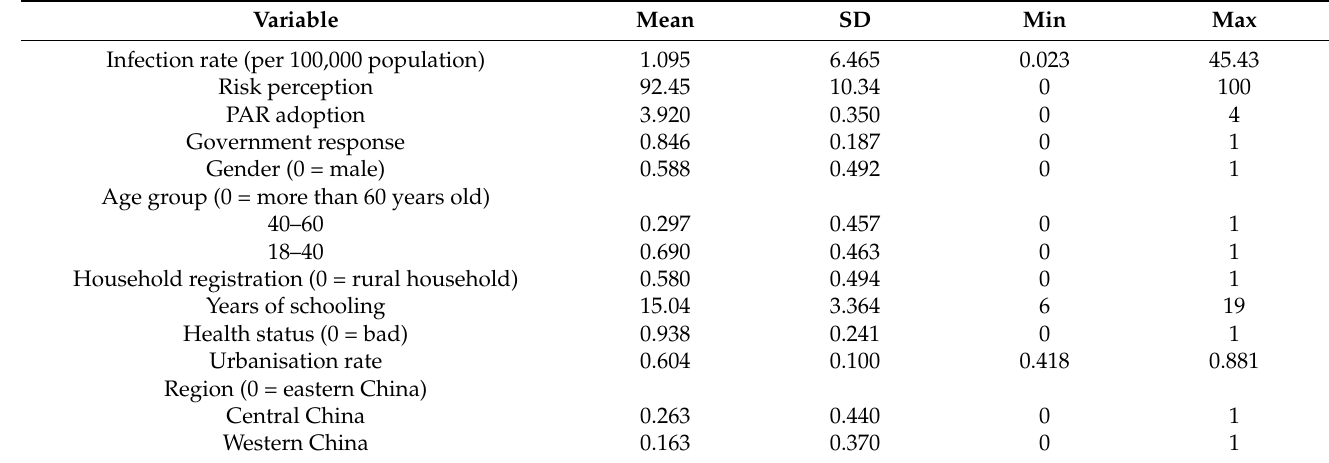
Table 2. Descriptive statistics for the main